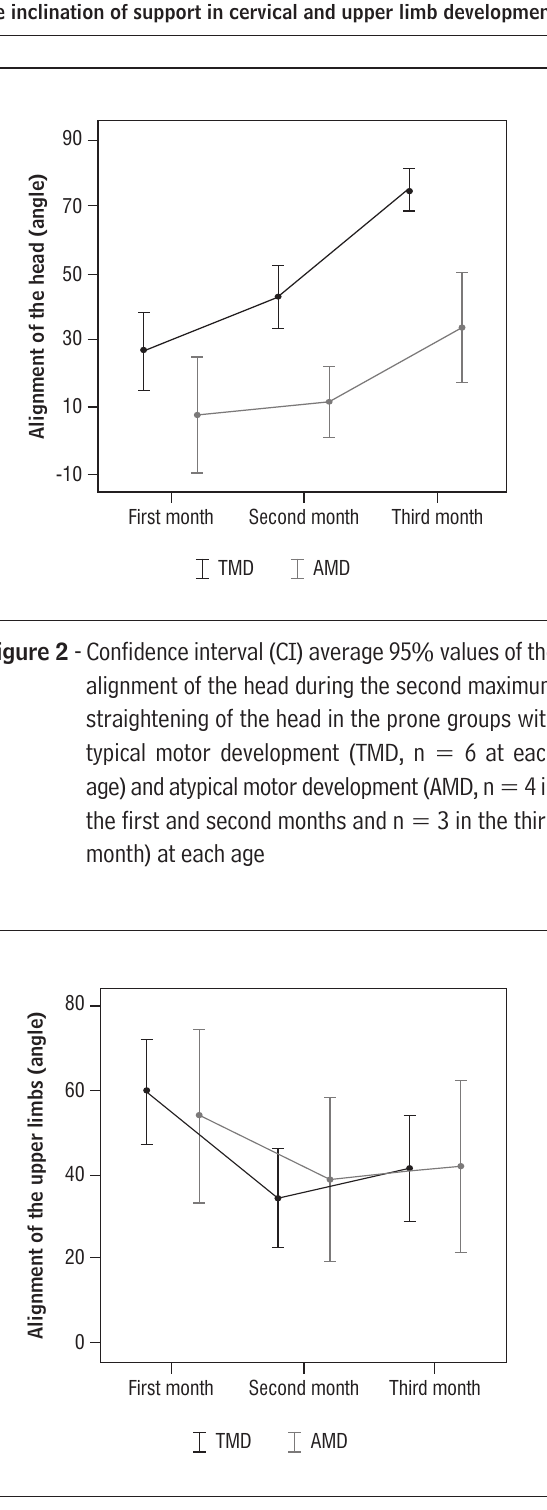
Figure 3 - Confidence interval (CI) average 95 % values of the alignment of the upper limbs during the second maximum straightening of the head in the prone groups with typical motor development (TMD, n = 6 at each age) and atypical motor develop- ment (AMD, n = 4 in the first and second months, n = 3 in the third month) at each